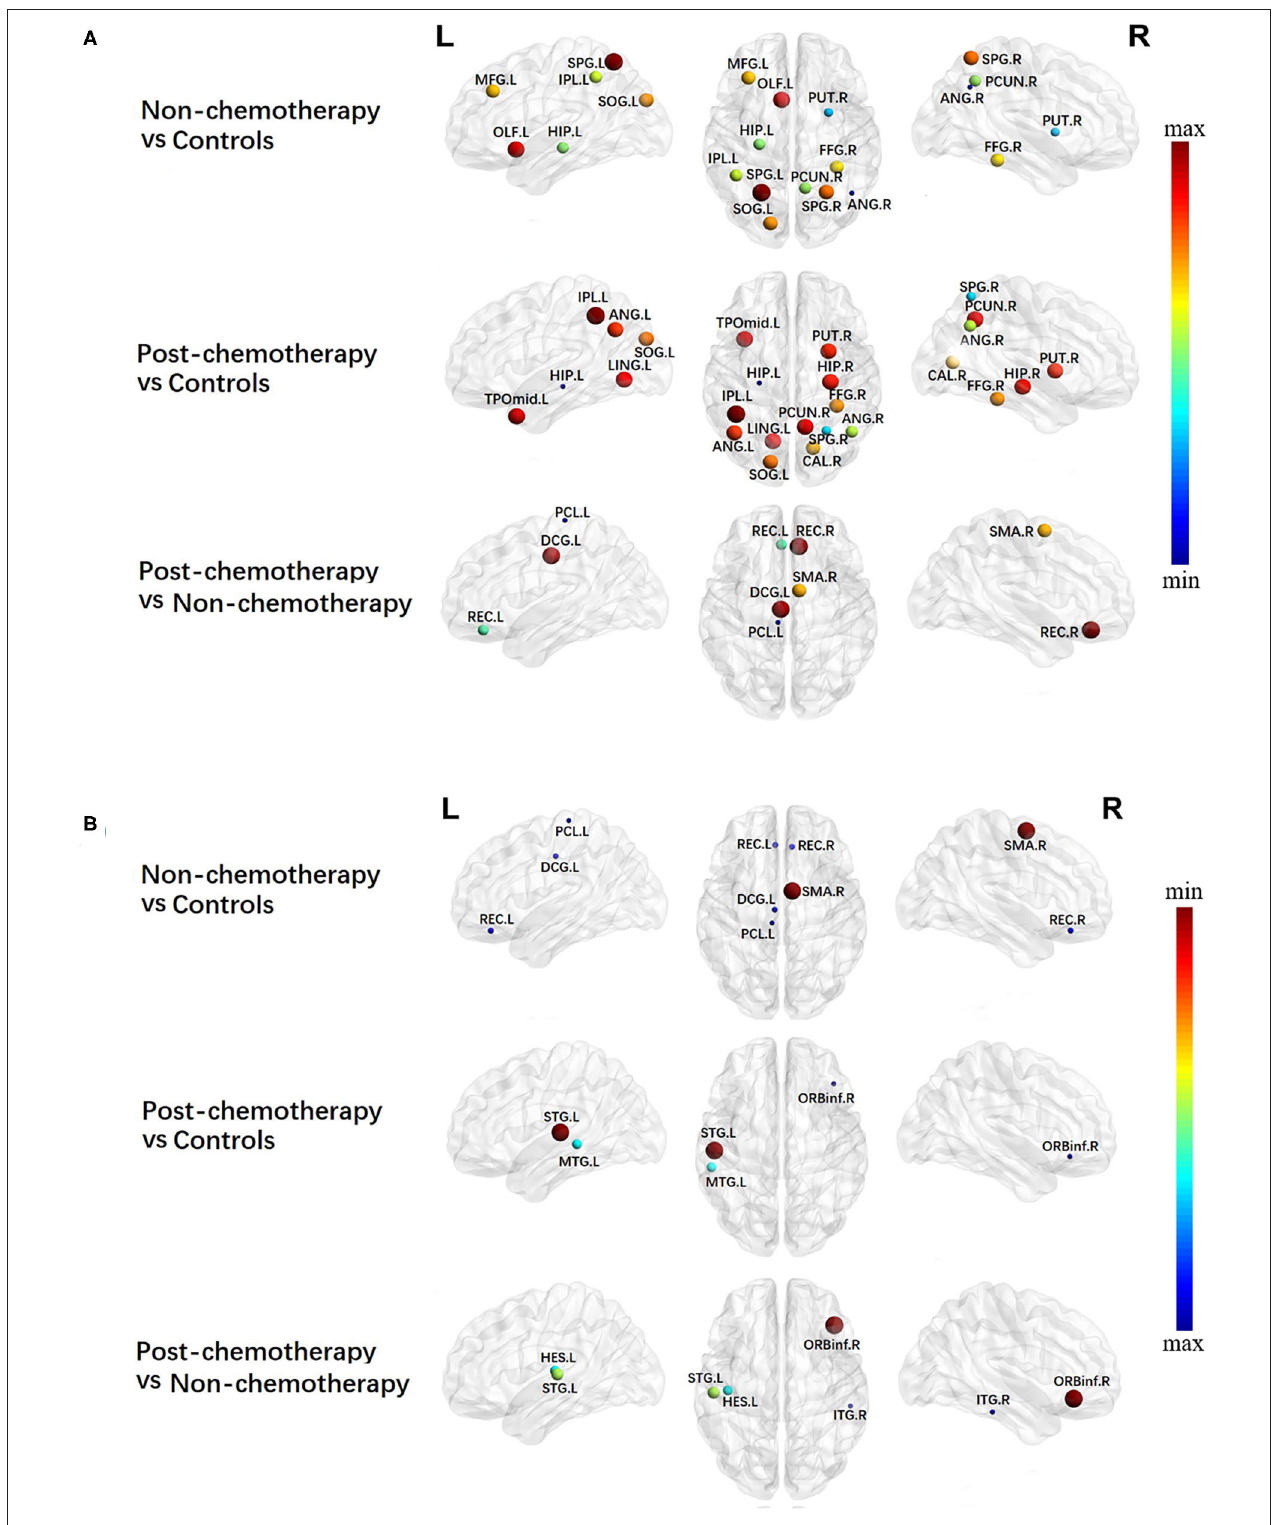
FIGURE 2 | Regions showing increased (A) and decreased (B) betweenness centrality in non-chemotherapy compared with healthy controls, post-chemotherapy compared with healthy controls, and post-chemotherapy compared with non-chemotherapy. The correction for multiple comparisons was performed